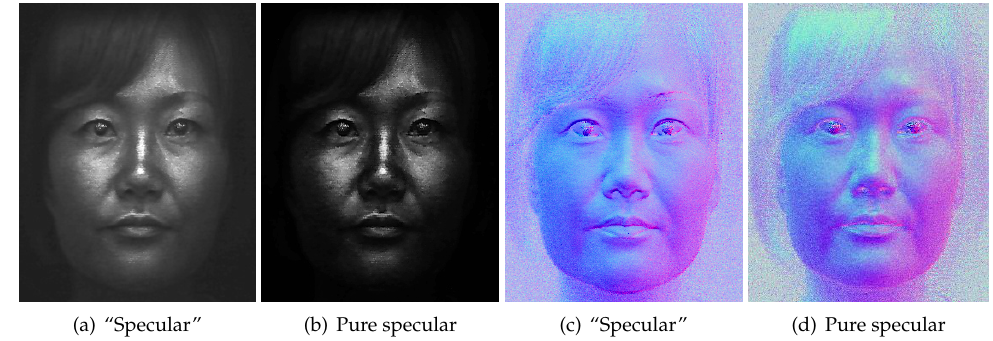
Figure 10. Removal of single scattering from specular reflectance in the polarization preserving component ( a ) for novel computation of pure specular albedo and photometric normals ( b ). Top row: specular albedo. Bottom row: specular normals (( c ) Eurographics Association 2016